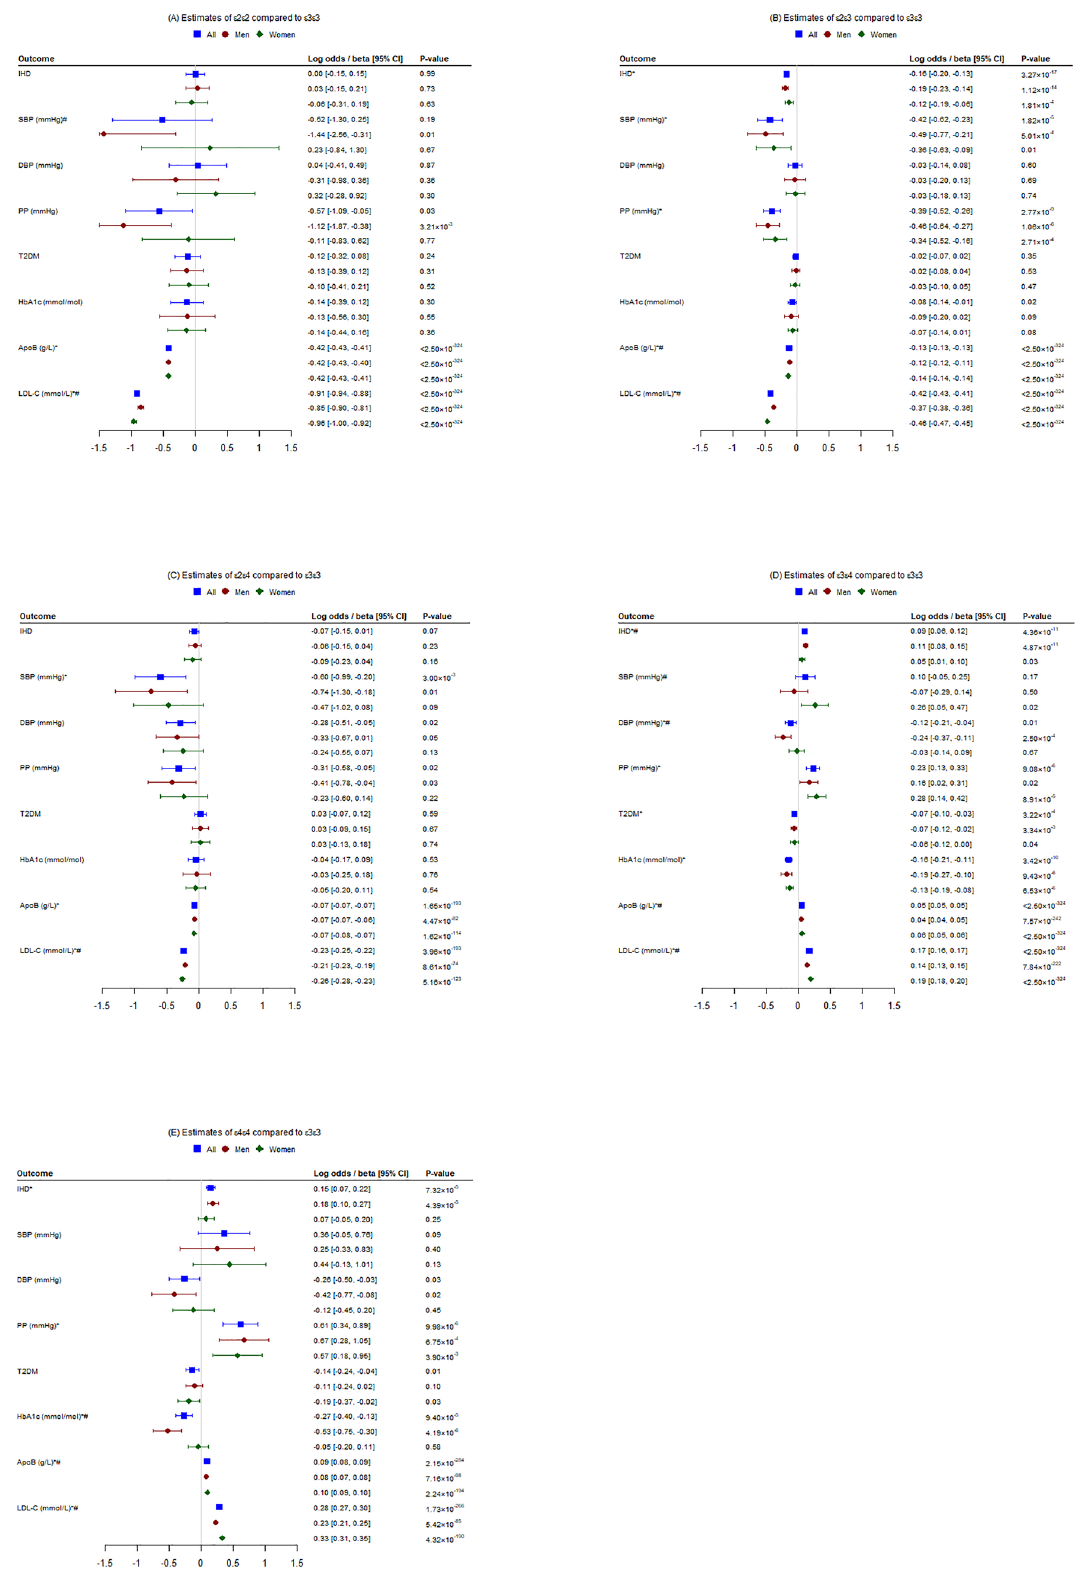
Figure 2. Associations of common APOE genotypes (ε2ε2, ε2ε3, ε2ε4, ε3ε4 and ε4ε4) with ischemic heart disease (IHD) and its risk factors [systolic blood pressure (SBP), diastolic blood pressure (DBP), pulse pressure (PP), type 2 diabetes (T2DM), glycated hemoglobin (HbA1c), plasma apolipoprotein B (apoB), and low- density lipoprotein cholesterol (LDL-C)] compared to ε3ε3 genotype overall and by sex in the UK Biobank ( *P value < 0.007, # P value from z tests comparing differences by sex <